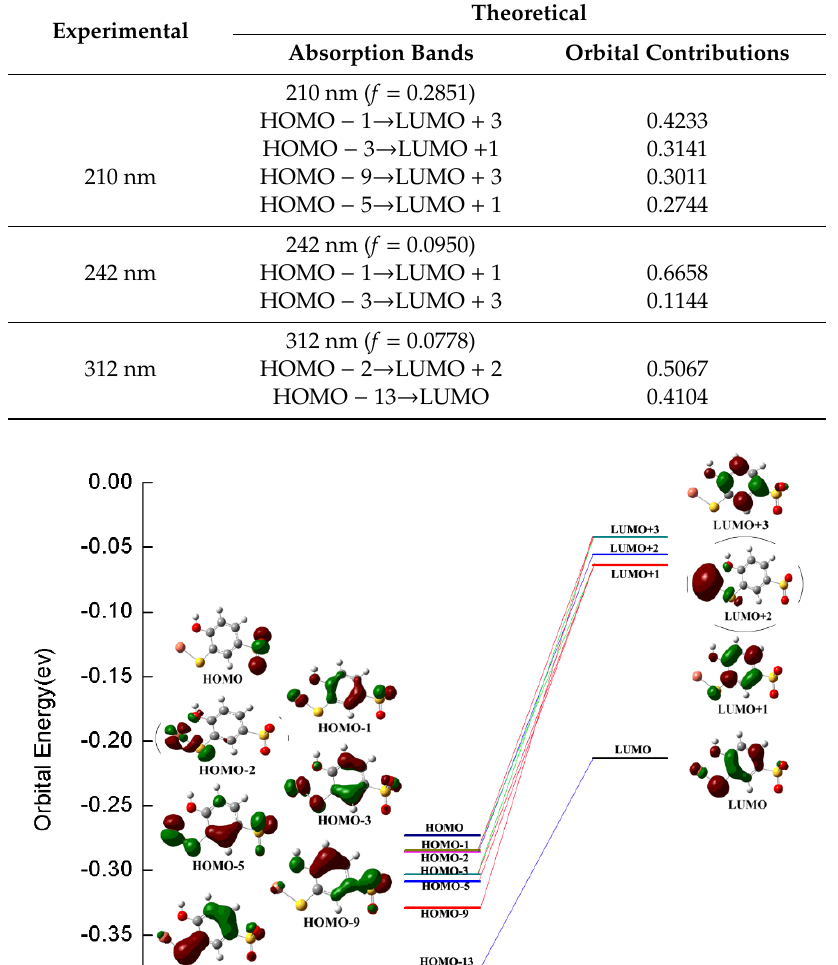
Table 1. Experimental and theoretical absorption bands, oscillator strengths, and orbital transition contributions.